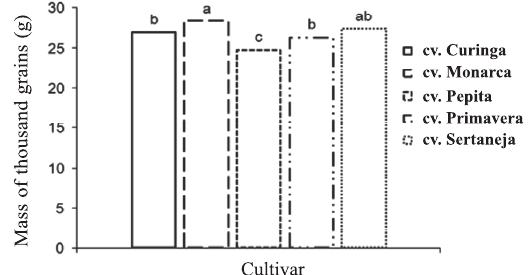
figure 5. mass of 1000 grains of rice cultivars. means followed by the same letter do not differ by the tukey test, at 5